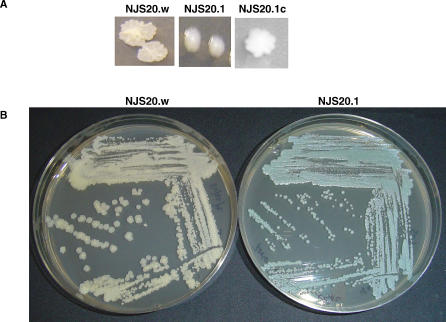
Morphology and β-Lactamase Activity of the lsr2::Tn5370 Mutant in M. smegmatis
(A) Magnification of individual colonies. Left, wild-type NJS20.w (control); center, NJS20.1 (lsr2 transposon mutant); right, NJS20.1c (complemented lsr2 transposon mutant).(B) Overall morphology and color of the two strains. Left, NJS20.w; right, NJS20.1